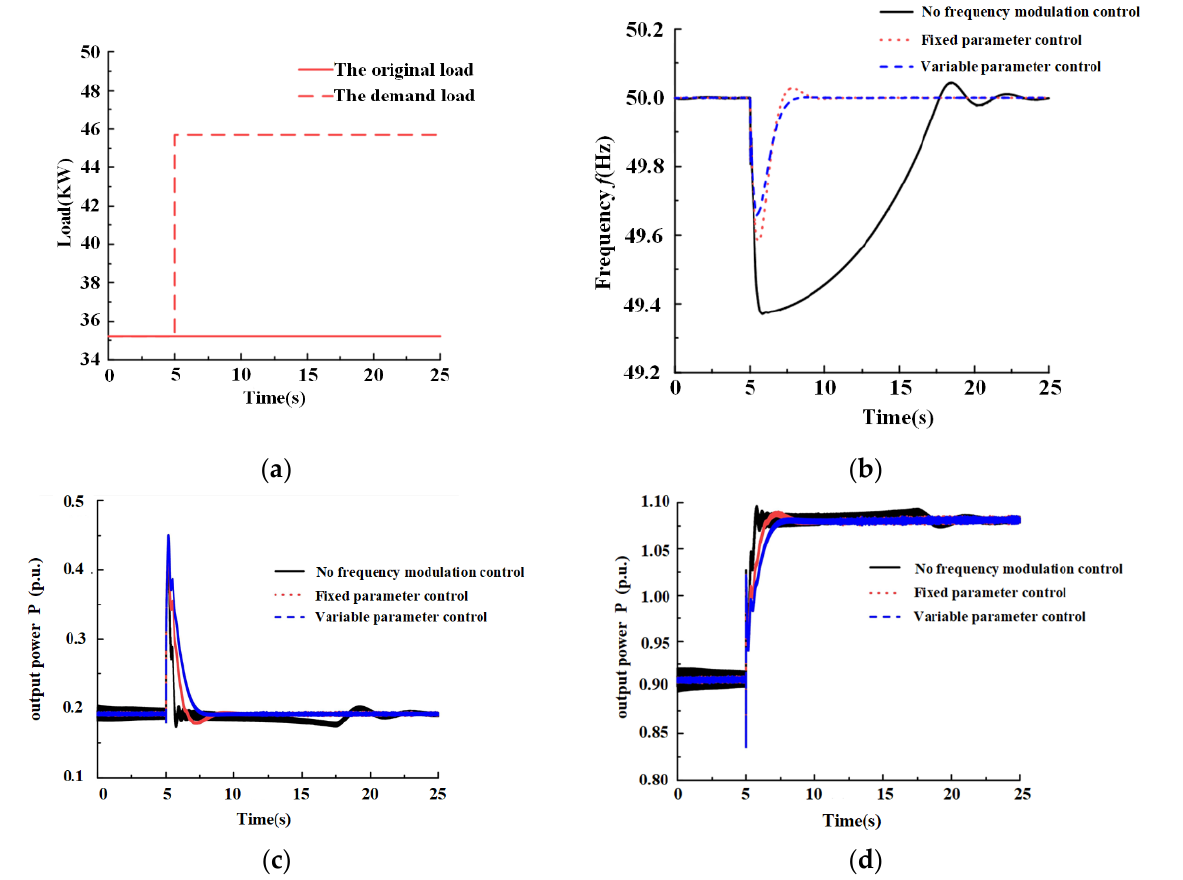
Figure 15. Comparison simulation curve of frequency modulation control with a load increase of 10.5 kW. ( a ) The demand load curve. ( b ) System frequency response curve. ( c ) Wind-driven generator output active power response curve. ( d ) Conventional generator output active power response curve.